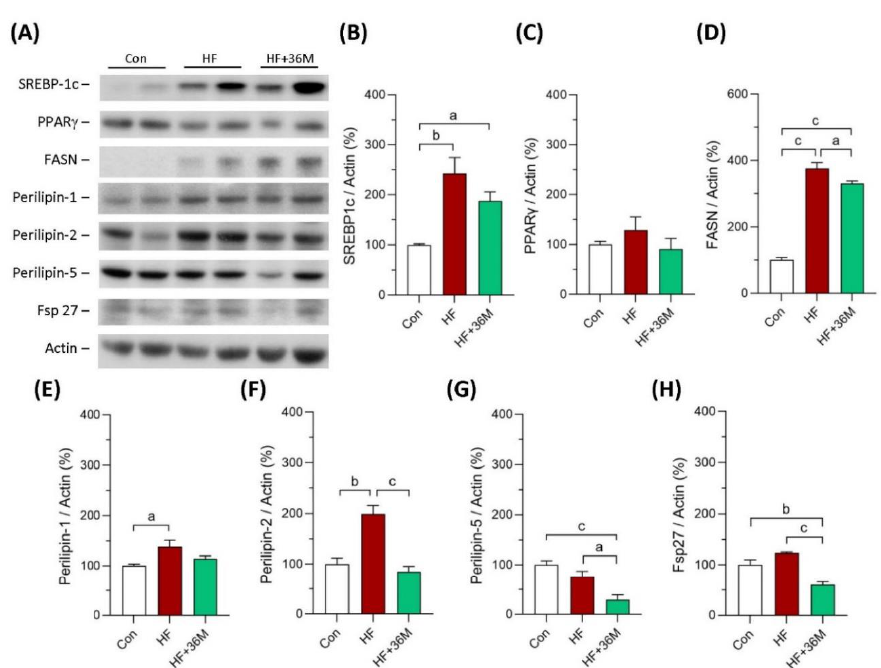
Figure 9. Expression of the proteins involving in lipogenesis in liver of the mice in the prevention model. ( A ) The representative immunoblot images for SREBP-1c, PPAR γ , FASN, perilipin 1, perilipin 2, perlipin 5, Fsp27, and β -actin. These protein expressions were detected by Western blotting. ( B – H ) The quantified results of the blots. Con: control; HF: high-fat diet. Data are mean ± SE (n = 8). a: p < 0.05; b: p < 0.01; c: p < 0.001.